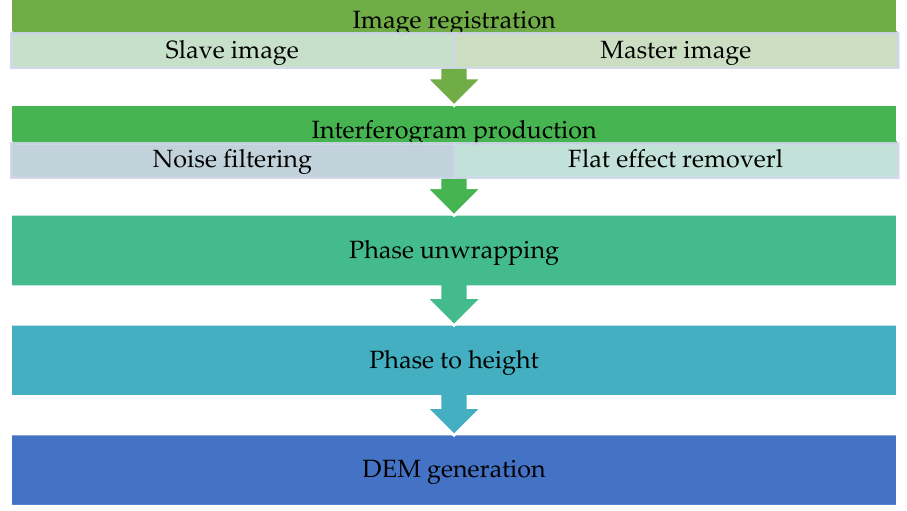
Figure 4. InSAR data-processing procedure for DEM production.